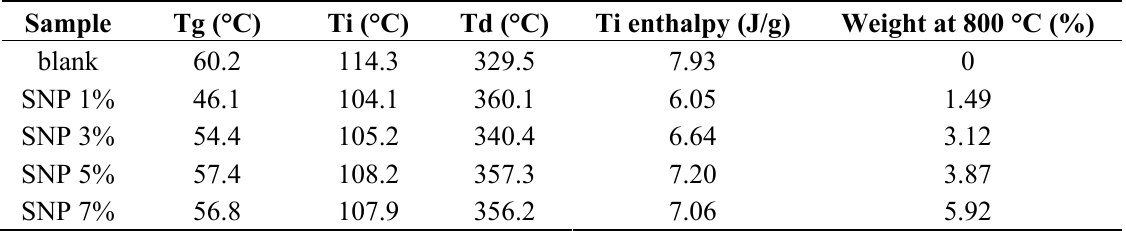
composites (xLCN/SNP) and blank xLCN sample. 2